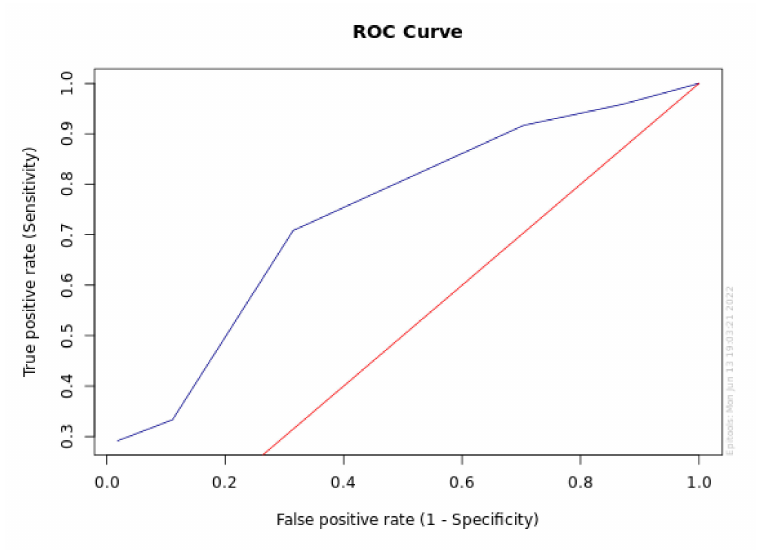
Figure 1. Sensitivity and specificity graph for MBL at T1.